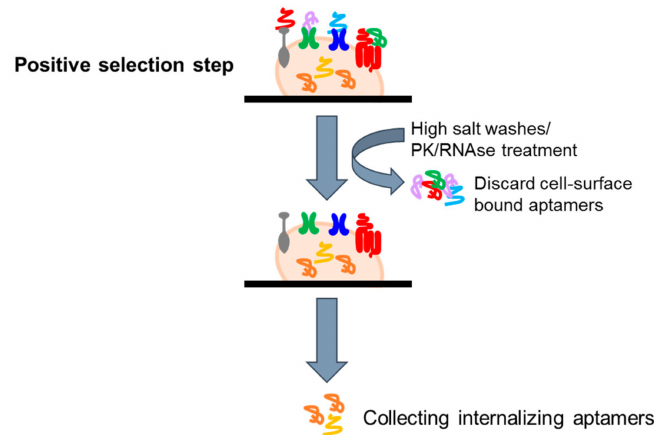
Figure 4. Scheme of protocols to isolate cell internalizing aptamers. Following the selection step, high salt washes or PK treatment are performed to remove cell surface bound aptamers and recover internalized